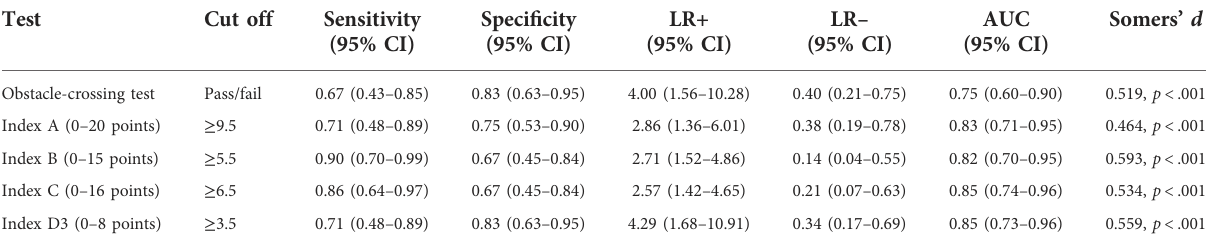
TABLE 3 Metrics for each index version and the obstacle-crossing test from the model derivation sample ( n =45) for predicting fall status at 3- months post discharge. Cut off scores were determined from ROC analysis. Values above the cut off indicate high fall risk. Somer ’ s d is for the binary variable using the indicated cut-off